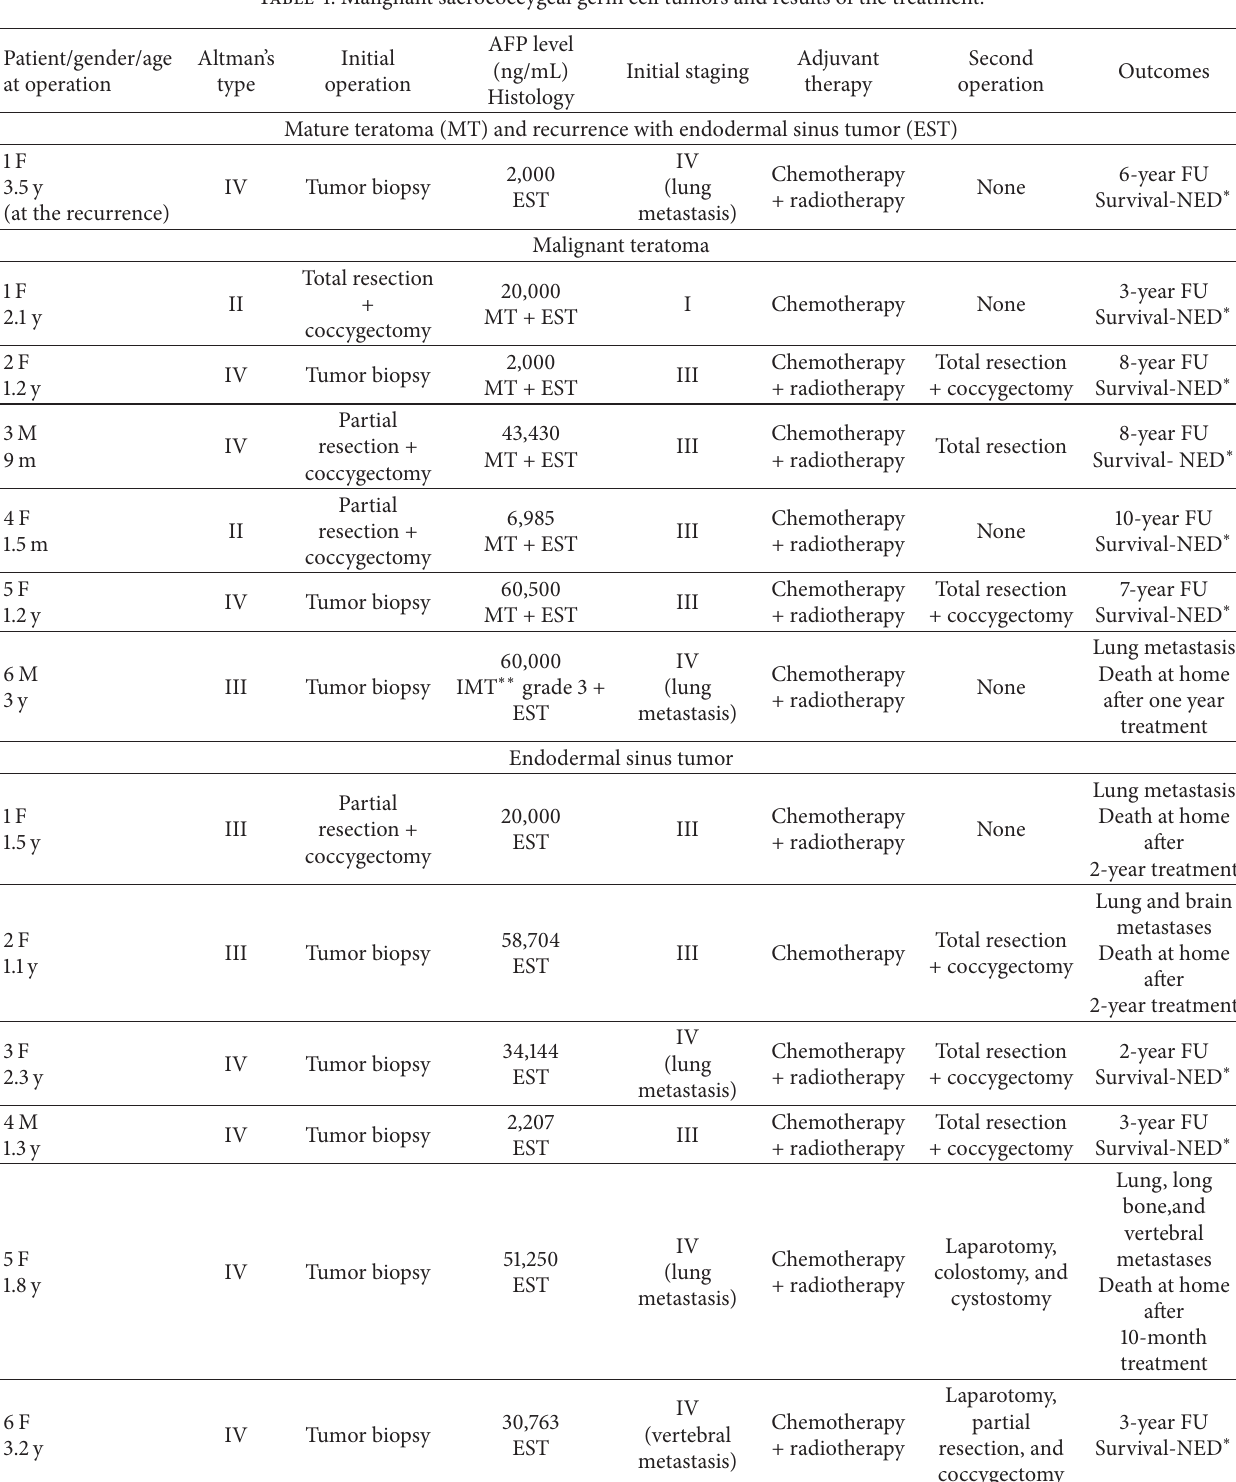
Table 4: Malignant sacrococcygeal germ cell tumors and results of the